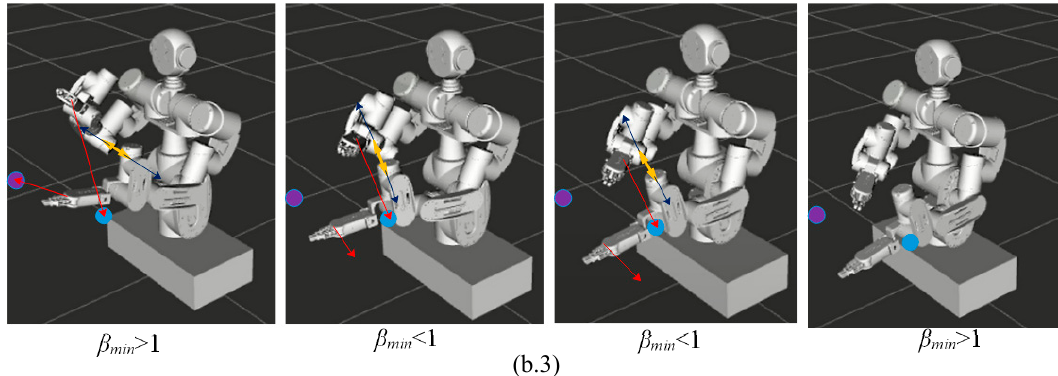
Figure 8. Process of avoiding self-collision in the dual-arm system. ( a.1 ) Left arm collides with right arm; the repulsive velocity acts on the end of the arm. ( a.2 ) Left arm collides with right arm; the repulsive velocity acts on link 5 on the right arm and on the end-effector on the right arm. ( b.1 ) Left arm collides with right arm; the repulsive velocity acts on link 6 on the left arm and on the end-effector on the right arm. ( b.2 ) Left arm collides with right arm; the repulsive velocity acts on link 6 on the right arm and on the end-effector on the left arm. ( b.3 ) Left arm collides with right arm; the repulsive velocity acts on link 6 on the right arm and on link 6 on the left arm. The repulsive vector ensures that the trajectory of the robot remains collision free.